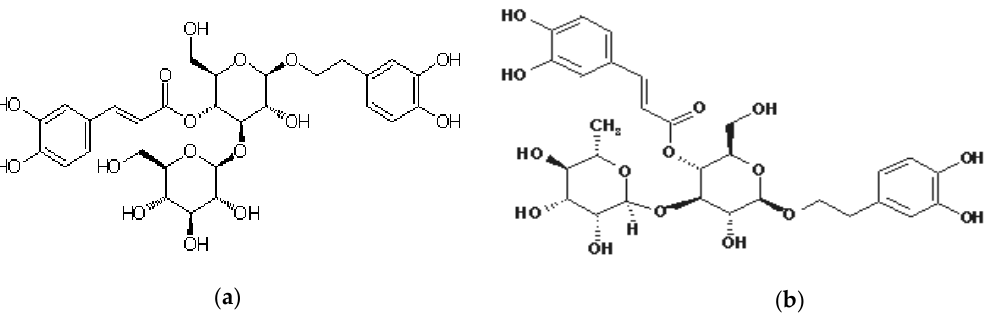
Figure 4. ( a ) Plantamajoside; ( b ) Acteoside.